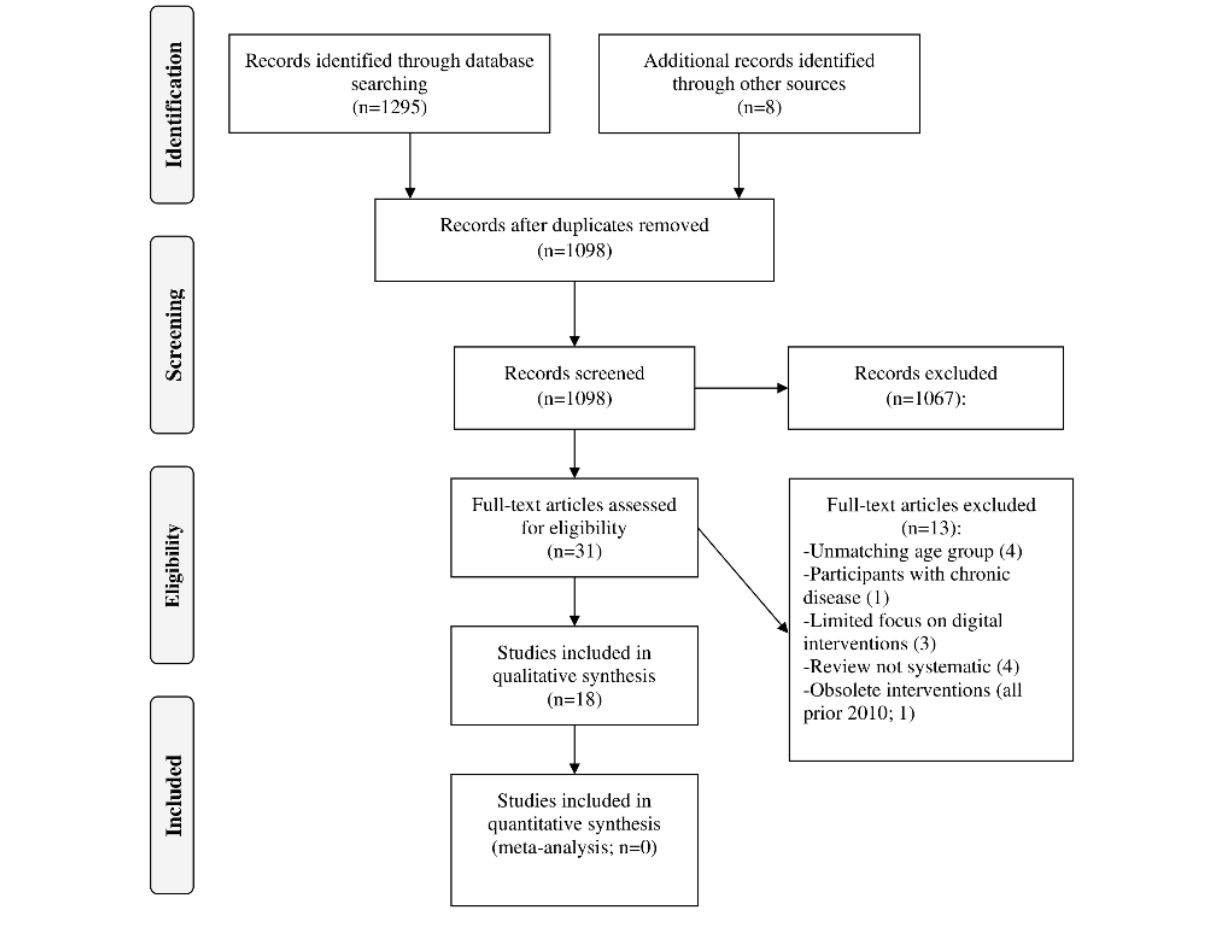
Figure 1. PRISMA (Preferred Reporting Items for Systematic Reviews and Meta-Analyses)